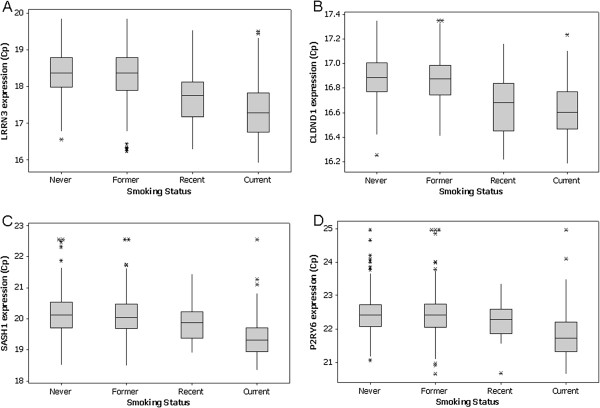
Expression levels of four most significant genes as assessed by qRT-PCR across 1074 PREDICT subjects grouped by self-reported smoking status. Expression levels are shown in Cp units on the Y axis, self-reported smoking status is shown on the X axis. (A) LRRN3; (B) CLDND1; (C) SASH1; (D) P2RY6.